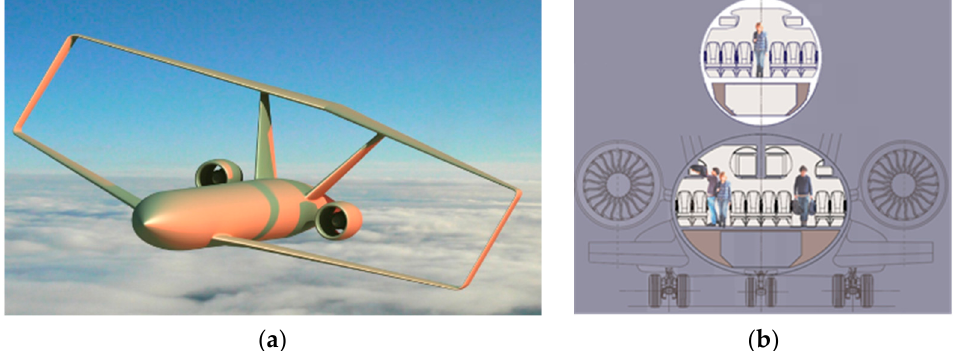
Figure 1. PARSIFAL project: ( a ) artistic representation of the box-wing aircraft object of study; ( b ) comparison between cabin cross-sections for conventional (top) and PARSIFAL cases (bottom).